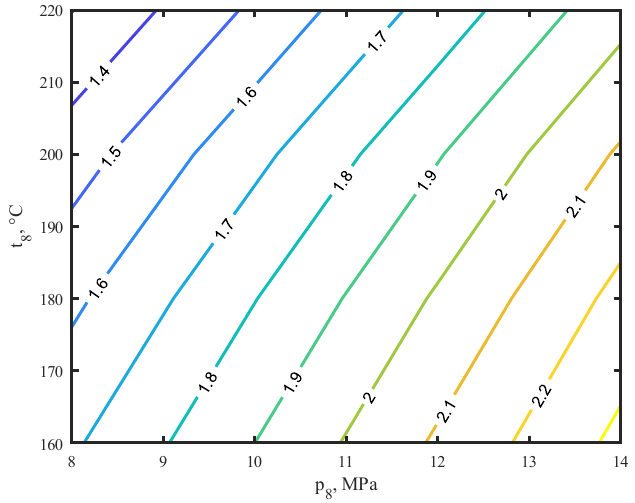
Figure 9. Influence of changes in pressure, p 8 , and temperature, t 8 , at the reactor inlet (Figure 3) on the yield of methanol, 𝑢 𝐶𝐻3𝑂𝐻 , in kg CH3OH /kg H2 . the yield of methanol, u CH 3 OH , in kg CH3OH /kg H2